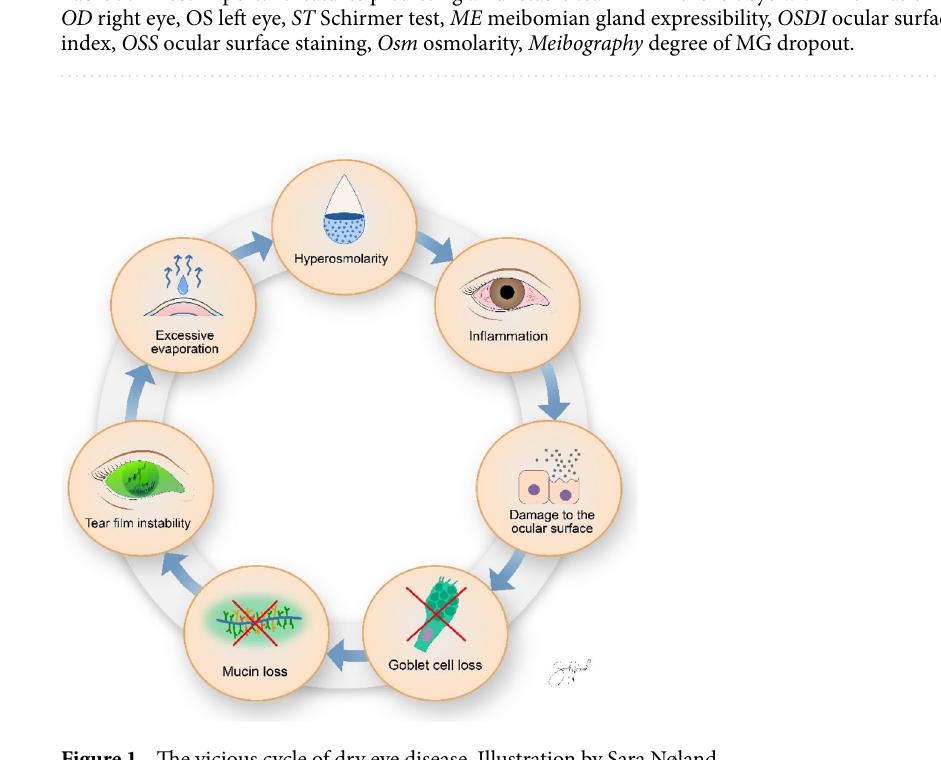
Figure 1. The vicious cycle of dry eye disease. Illustration by Sara